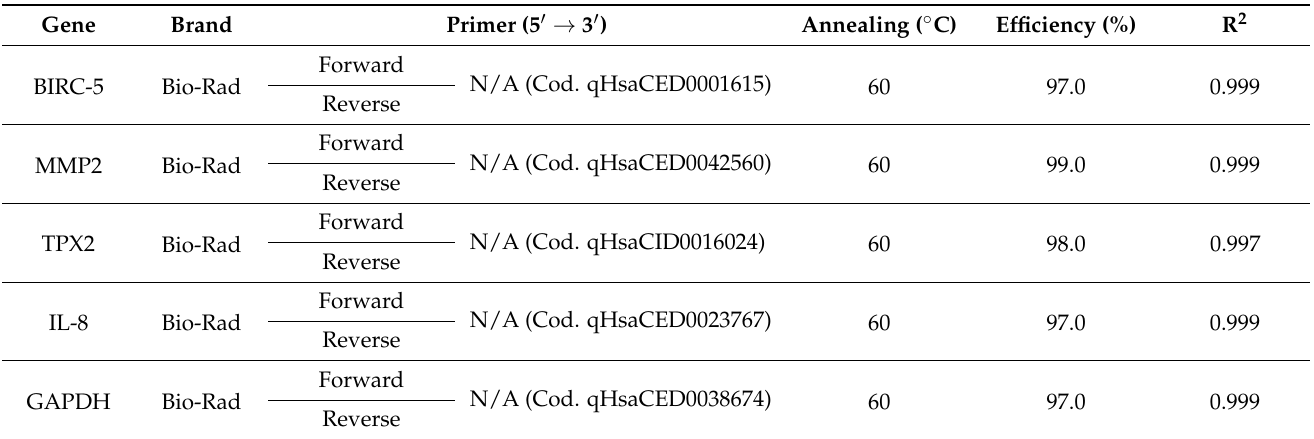
Table 1. List of oligonucleotides, general conditions, and validation parameters used to perform